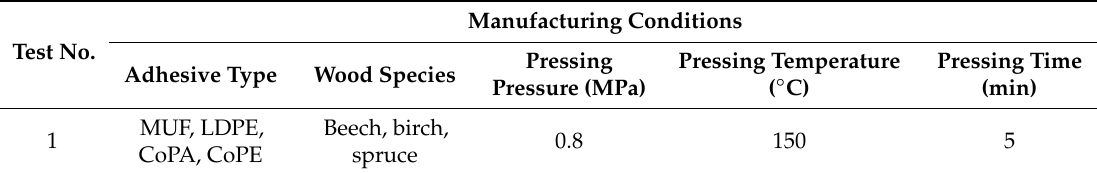
Table 2. Manufacturing conditions of